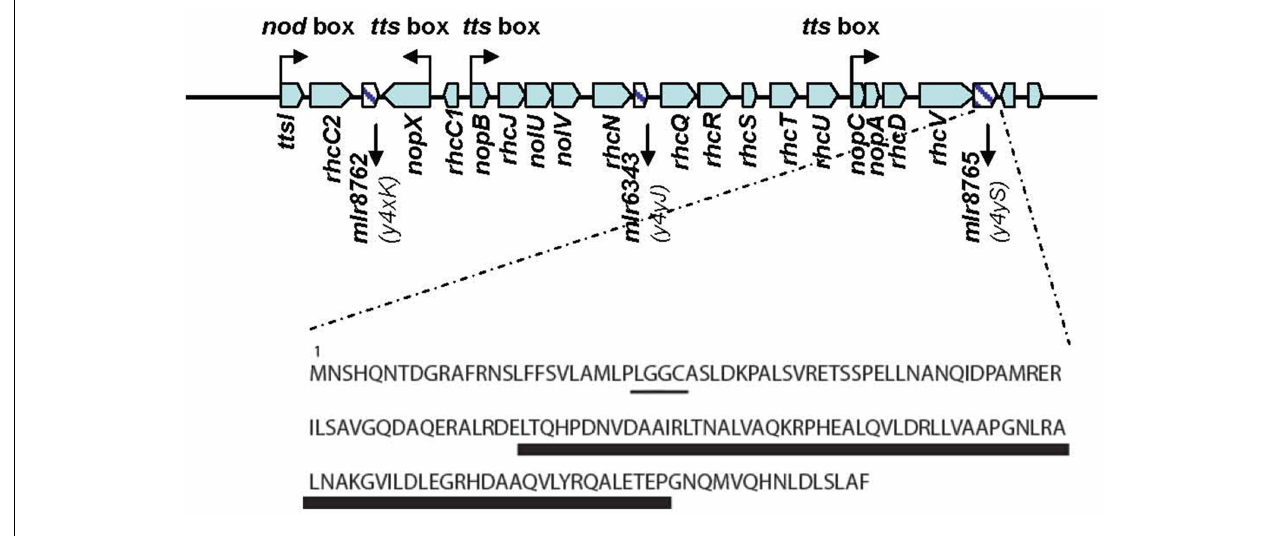
FIGURE 1 | The T3SS locus of MAFF303099. Predicted cis -elements are shown. Three open reading frames (ORFs) corresponding to genes coding for unknown proteins are shown as hatched bars. Characteristic features of the